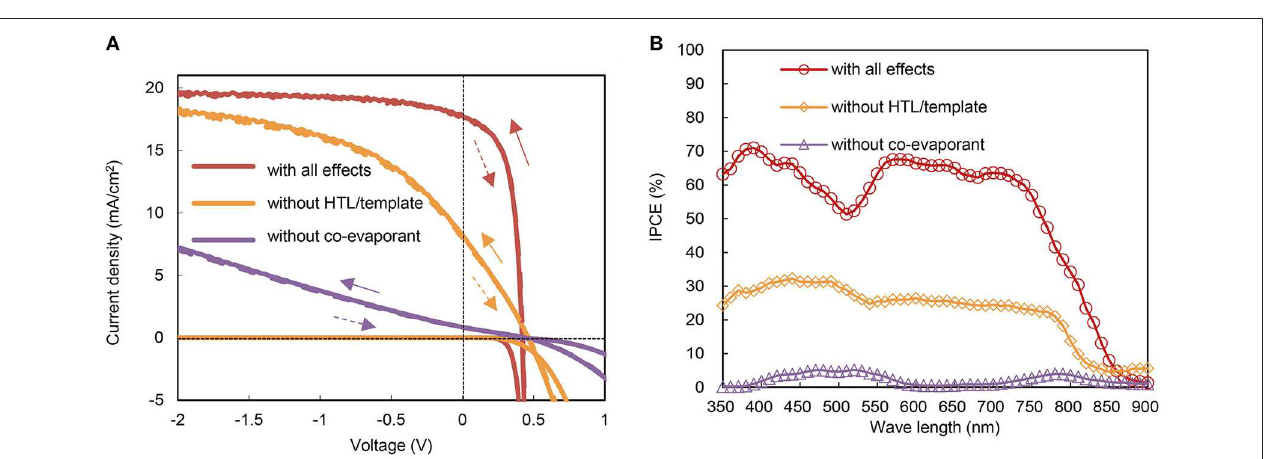
FIGURE 6 | Thickness dependence of reflectance. (A) R glass & active , reflectance of the device on flat ITO without Ag electrode. (B) R glass & active , reflectance of the device on textured FTO without Ag electrode. (C) R device , reflectance of the device on textured ITO covered with Ag electrode mirror. (D) R device , reflectance of the device on textured FTO with Ag electrode mirror.